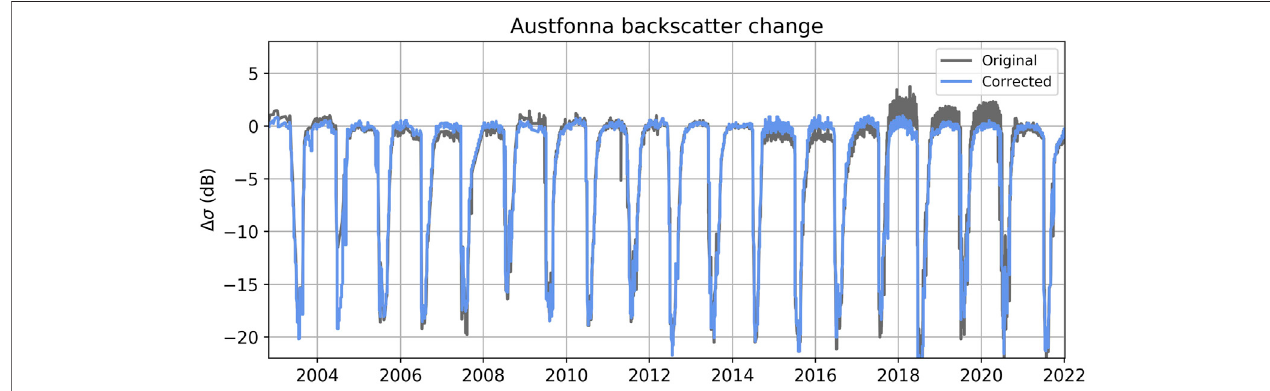
FIGURE3| Time series ofrelative radarbackscatterforHH-polarization (dark grey)afora1×1 kmarea(79.86 N, 24.39 E) onAustfonna. The bluelinerepresents the corrected relative signal, where the winter mean (November 1 – April 30) has been subtracted from the relative backscatter signal in order to be able to perform threshold detections for wet snow.